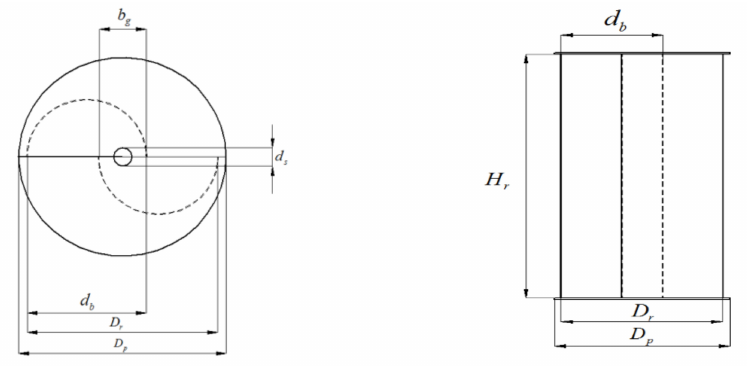
Figure 2. SAVONIUS rotor model principal design parameters